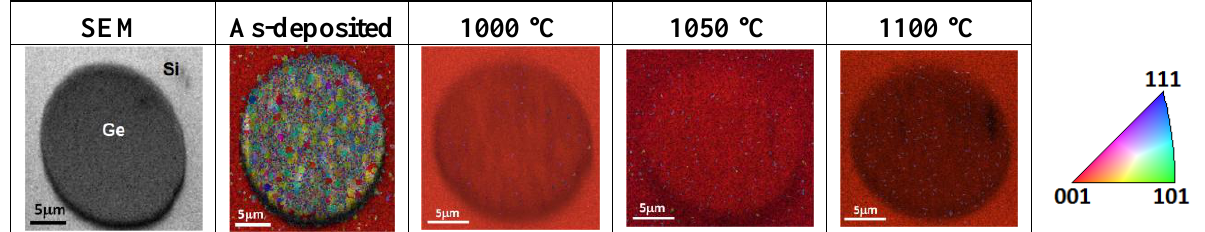
Figure 2. SEM and EBSD images of annealed Ge/Si at different